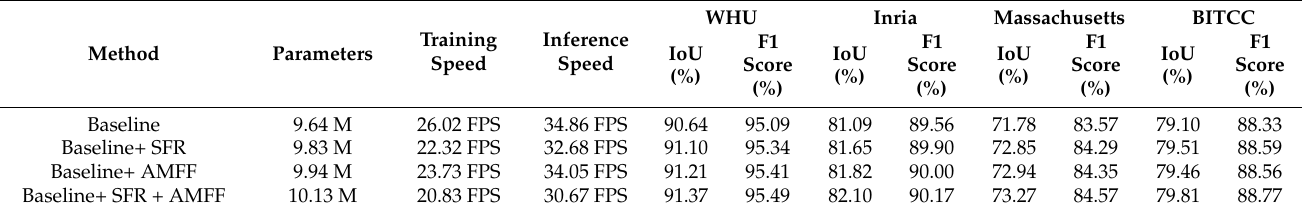
Table 3. Ablation study of various module combinations with four